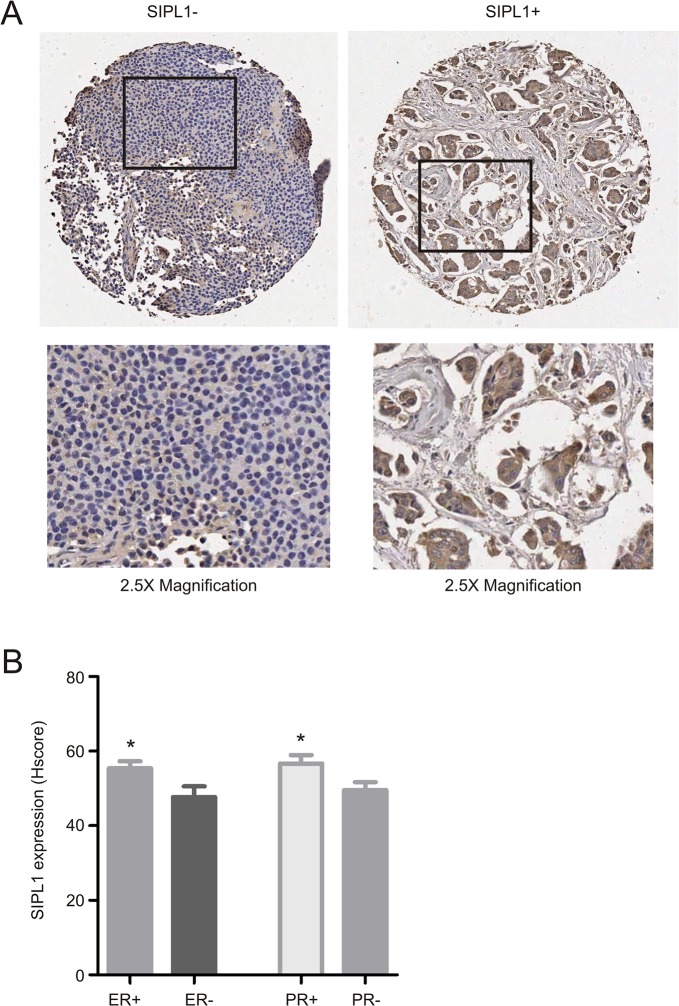
SIPL1 protein expression is associated with ER+ and PR+ tumours.(A) A TMA was examined for SIPL1 protein expression using IHC. Typical images of SIPL1+ and SIPL1- tumors are shown. The marked regions were enlarged 2.5 fold and placed underneath of the individual images. (B) SIPL1 staining was quantified (see Materials and Methods for details); means ± SEM (standard error mean) are graphed. * p<0.05 (unpaired, two-tailed, welch-corrected t-test).